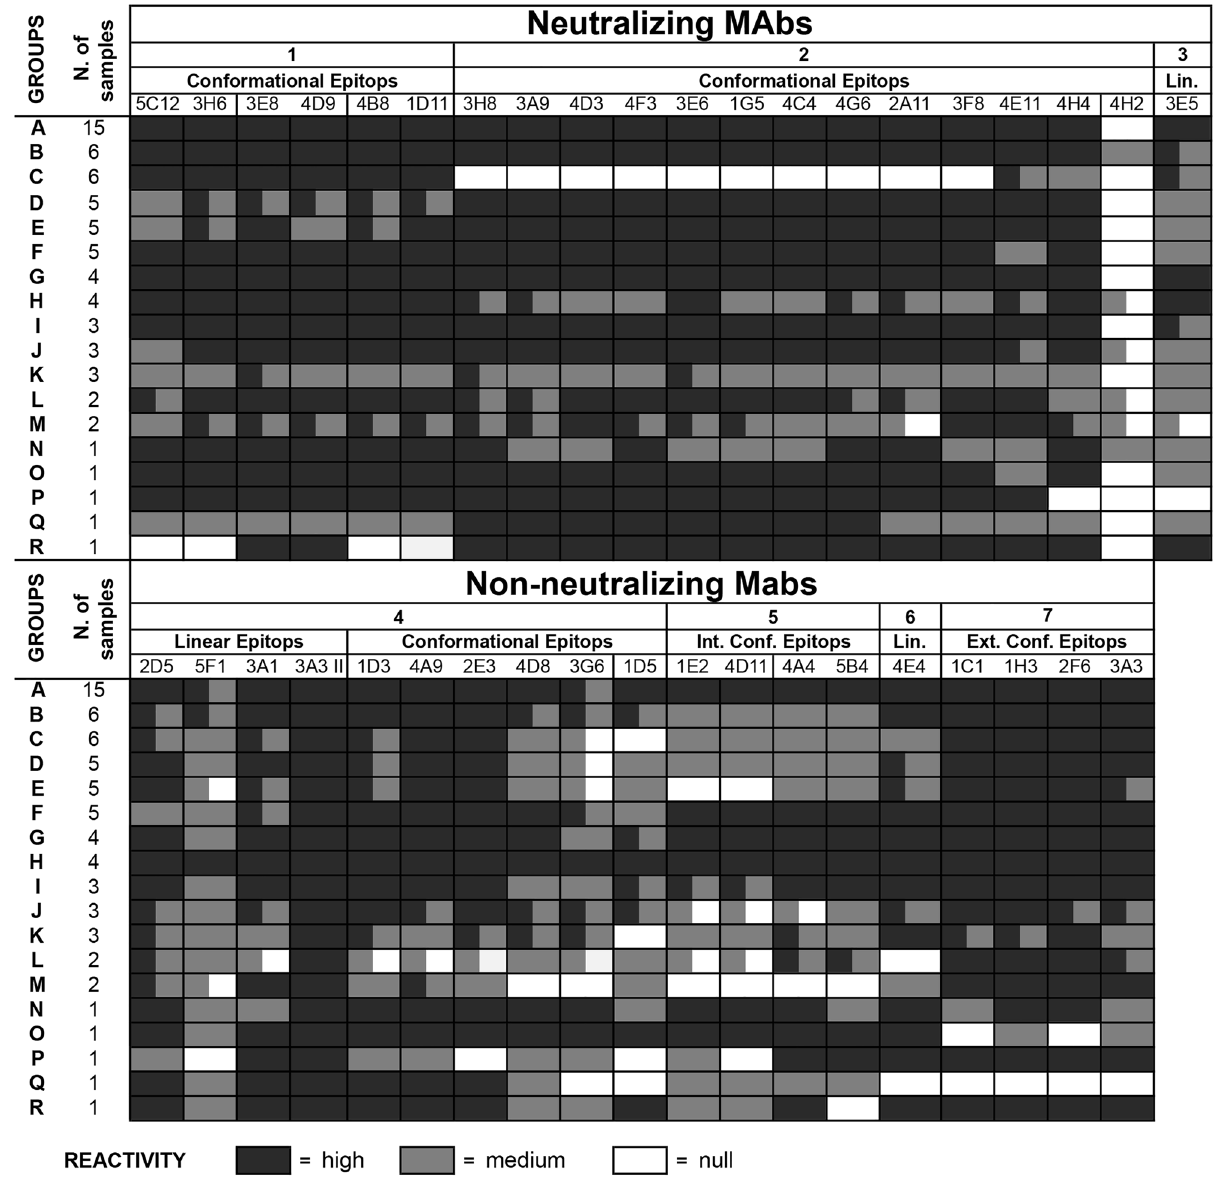
Figure 3. Characterization of antigenic profile of recent isolates. Graphical representation of reactivity of MAbs against recent EMCV isolates considered in the analysis. The upper rows of the tables indicate MAbs features: names, epitopes’ characteristics, areas and eventual involvement in viral neutralization. Letters from A to R, on the left, indicate the groups generated clustering analysed samples accordingly to homogeneity in induce antibody reactivity, and the size of each group is indicated alongside. Colours of squares denote reactivity level: black, high; grey medium; white, null. The picture revealed an overall homogeneity of reactivity of MAbs listed in area 1, 2 and 7 and a discrete, but occasional and unfixed, variability of the other MAbs. Maintenance of high reactivity of 3A3 II (completely black column) and loss of reactivity of 4H2 (almost completely white column) are evident in the picture. Even changes in epitopes of area 2 of samples clustered in Group C, with consequent loss of reactivity by specific MAbs, are clearly